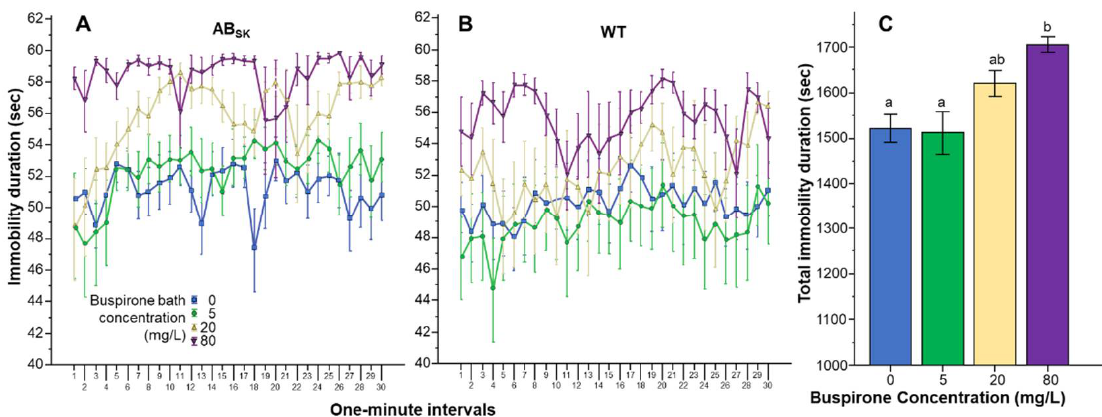
Figure 2. Duration of immobility is dose dependently increased by buspirone. Immobility duration as a function of time (1-min intervals) is shown for ABSK ( A ) and WT ( B ) zebrafish. The legends show the buspirone concentrations employed (blue line with rectangle 0 mg/L, green line with circle 5 mg/L, yellow line with triangle 20 mg/L, and purple line with upside down triangle 80 mg/L). ( C ) shows the cumulative (total) duration of immobility for the entire 30 min recording session, pooled for the two populations, exhibited by the zebrafish exposed to the different concentrations of buspirone (indicated underneath the X axis and also by the same color coding as in ( A , B )). Means + S.E.M. are shown. The results of Tukey HSD test are shown as letters above each bar of the bar graph ( C ). Bars that do not share one letter in common represent buspirone treatment groups that are significantly ( p < 0.05) different from each other. For detailed results of statistical analyses, see Results.